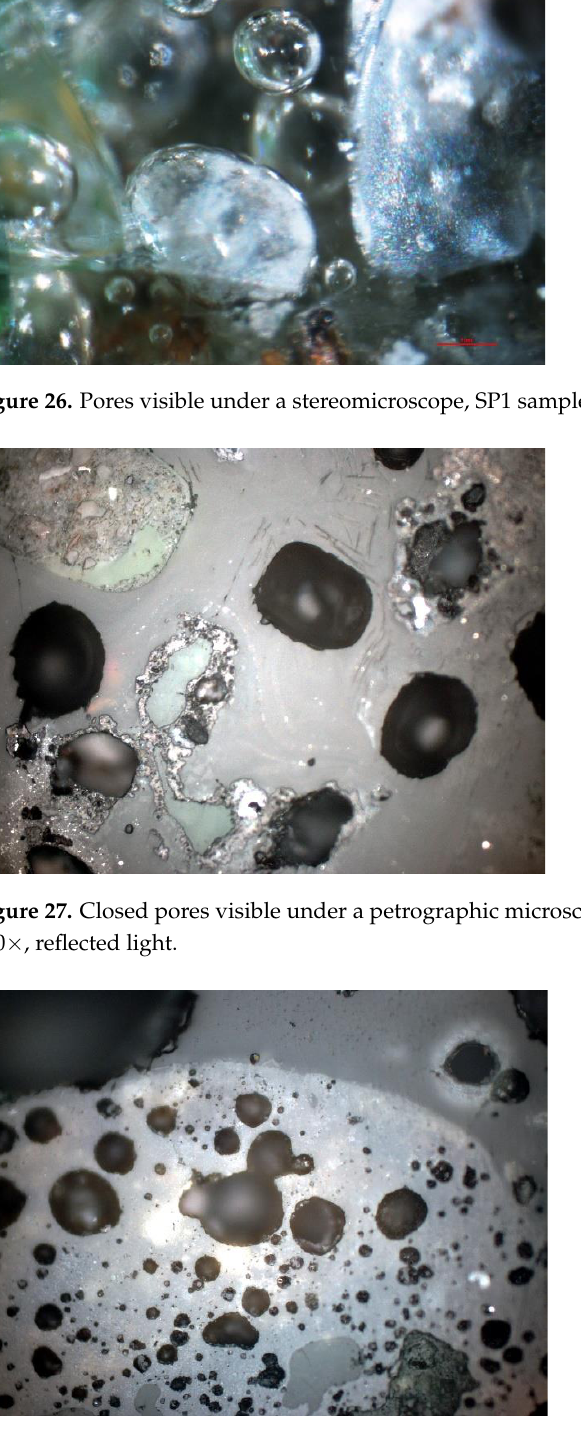
Figure 29. Closed pores visible under a petrographic microscope, polished section, 1P, 100×, re- flected light. Quantitative analysis results, aimed at examining the effect of material porosity de- pending on the analyzed fraction, are presented in Table 2 and in Figure 30. Figure 30. Porosity dependence on the analyzed grain fraction (SP2 sample). Table 2. Porosity of individual grain fractions (SP2 sample). Sample fraction (mm)